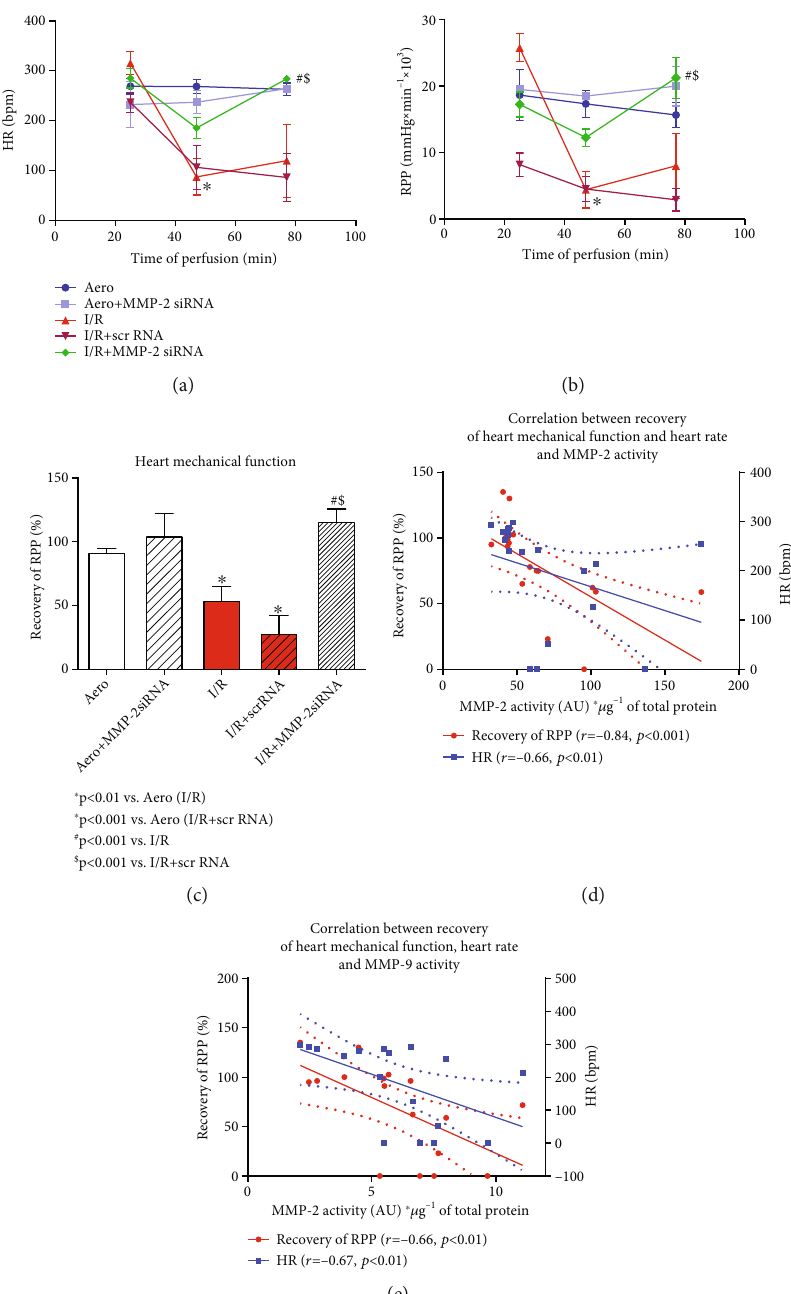
Figure 3: An in fl uence of MMP-2 siRNA on heart function: heart rate (a). RPP calculated as the product of the heart rate and left ventricular developed pressure (heart rate x left ventricular developed pressure/1000) (b). Recovery of heart mechanical function (di ff erence between RPP at 25 th and 77 th min of perfusion expressed as a percentage of RPP recovery) (c). Correlation between heart mechanical function recovery, heart rate and MMP-2 activity (d); MMP-9 activity (e) in heart homogenates; straight line: standard curve; dotted line: 95% con fi dence band. Aero: aerobic control group; bpm: beats per minute; HR: heart rate; I/R: ischemia-reperfusion group; MMP-2: matrix metalloproteinase 2; MMP-9: matrix metalloproteinase 9; RPP: rate pressure product. Mean ± SEM , n Aero = 3 ; = 2 ; n = 5 ; n = 5 ; n = 4 . ∗ p < 0 : 05 vs. Aero, # p < 0 : 05 vs. I/R, and $ p < 0 : 05 vs. n Aero+MMP − 2siRNA I/R I/R+scrRNA I/R+MMP − 2siRNA